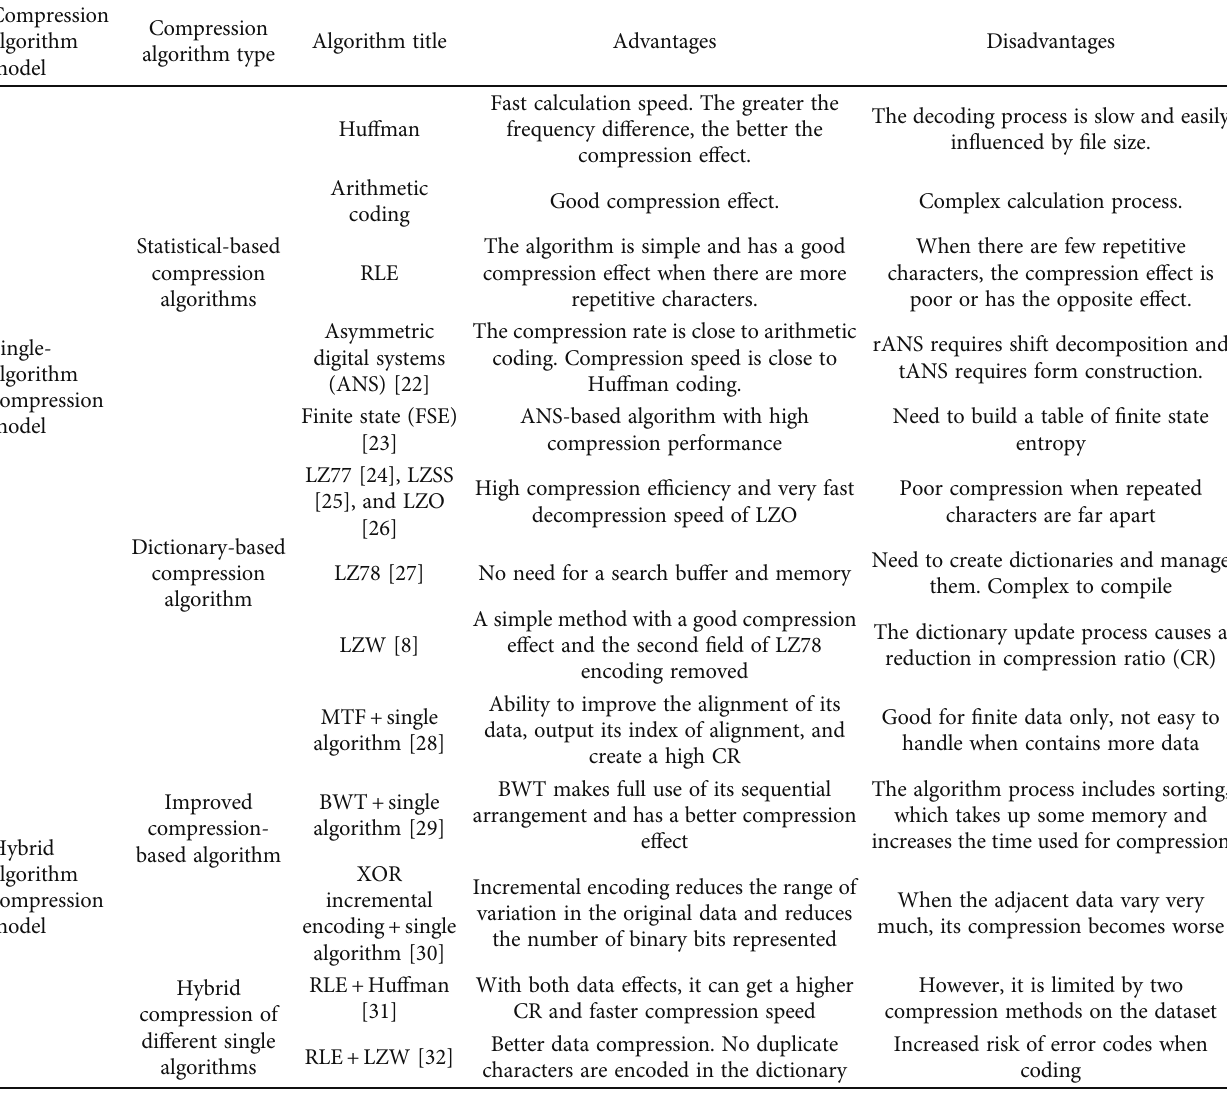
Table 1: Lossless compression